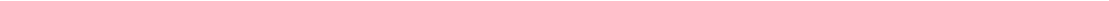
Fig. 2 Pellino2 mediates activation of the NLRP3 pathway. ELISA of a IL-1 β and b IL-18, and c LDH assay of medium from WT and Peli2 − / − BMDMs treated with 100 ng/ml LPS for 3 h with or without further stimulation with 2.5 mM ATP for 1 h. UT, untreated. d Immunoblot analysis of IL-1 β and Caspase-1 in medium (Sup) and lysates from WT and Peli2 − / − BMDMs stimulated with 100 ng/ml LPS for 3 h with or without further stimulation with 2.5 mM ATP for 1 h or transfection of Poly (dA:dT) (1 μ g/ml) for 6 h. ELISA of e IL-1 β and f IL-18 and g LDH assay of medium from WT and Peli2 − / − BMDMs treated with 100 ng/ml LPS for 3 h with or without further stimulation with 5 mM Nigericin for 1 h. h Immunoblot analysis of IL-1 β and Caspase-1 in medium (Sup) and lysates from WT and Peli2 − / − BMDMs stimulated with 100 ng/ml LPS for 3 h with or without further stimulation with 5 mM Nigericin for 1 h or transfection of Poly (dA:dT) (1 μ g/ml) for 6 h. i ELISA of IL-1 β of medium from WT and Peli2 − / − BMDMs treated with 100 ng/ml LPS for 3 h with or without further stimulation with the indicated concentrations of Alum for 6 h. j ELISA of IL-1 β in medium from peritoneal-resident macrophages isolated from WT and Peli2 − / − mice. Cells were treated with 100 ng/ml of LPS for 3 h with or without further stimulation with 2.5 mM ATP for 1 h. k-m Human THP1 cells were transfected with human Pellino2-speci fi c siRNA or control siRNA. k Quantitative RT-PCR analysis of PELI2 expression in transfected cells. l ELISA of IL-1 β in medium from transfected THP1 cells stimulated with 100 ng/ml LPS for 6 h with or without further treatment with 2.5 mM ATP or 5 mM Nigericin for 1 h. m Immunoblot analysis of IL-1 β and Caspase-1 in medium (Sup) and lysates from transfected THP1 cells stimulated with 100 ng/ml LPS for 6 h with or without further stimulation with 2.5 mM ATP or 5 mM Nigericin for 1 h. β -Actin was used as loading controls. * p < 0.05 (paired, two-tailed Student ’ s t -test). Data are biological replicates that are representative of three independent experiments. Error bars,